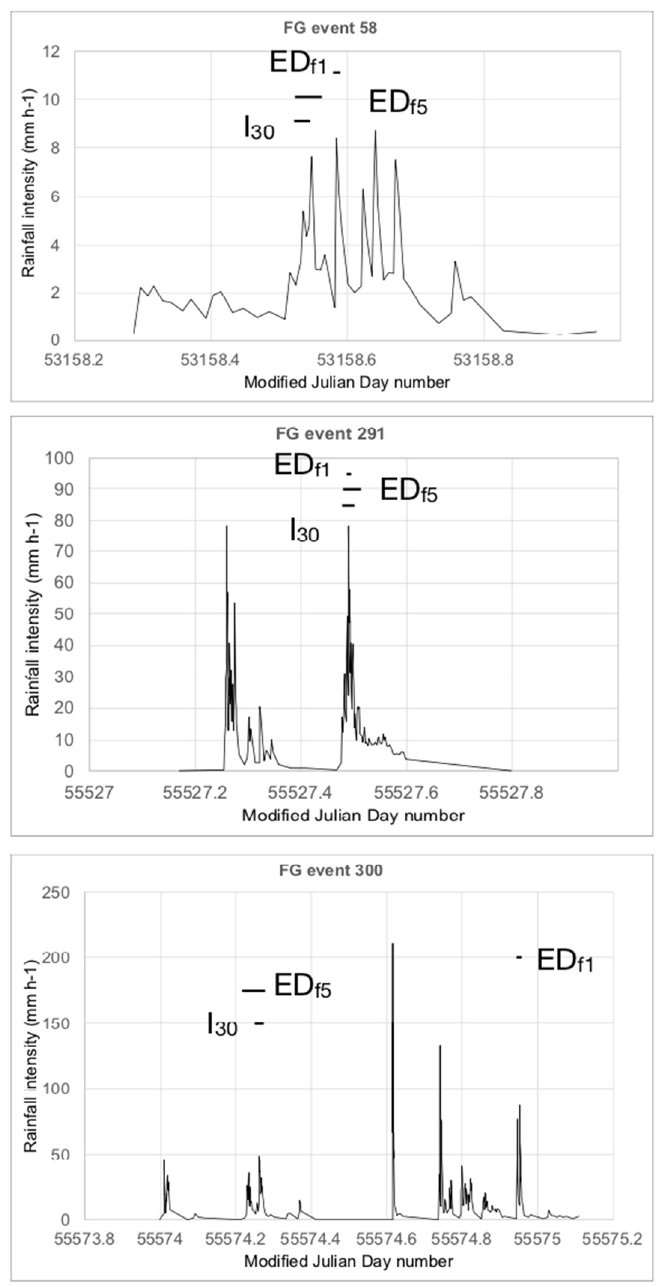
Figure 1. Position of the time intervals of I 30 (wettest 30-minute interval within a rainfall event), ED f1 , and ED f5 in FG rainfall events 58, 291, and 300. Refer to text for details.